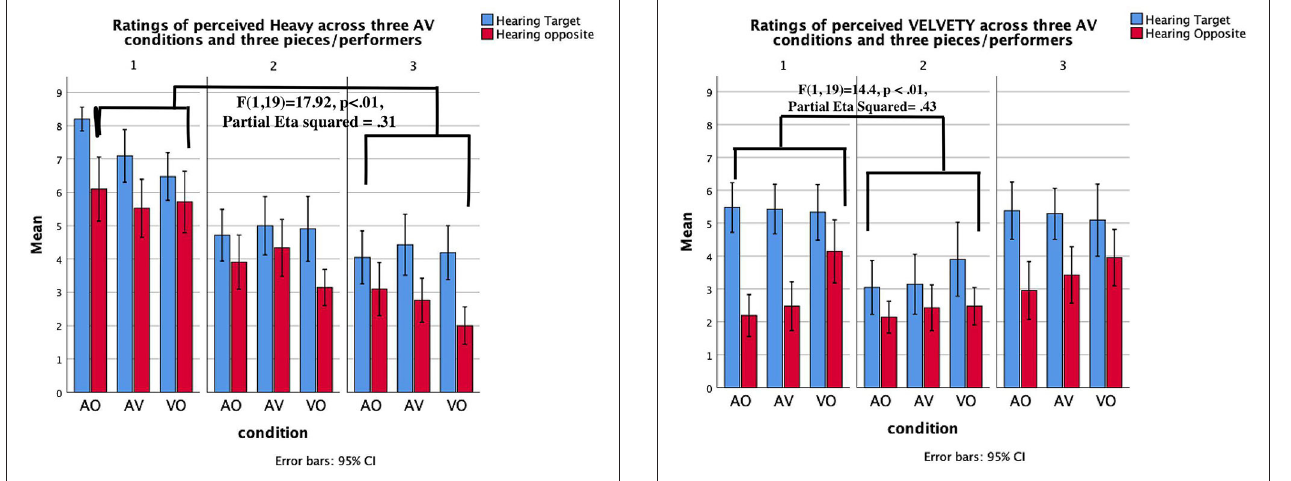
vs. dark, bright vs. light) by three performers. We compared the aural/visual information in pairs, to explore whether the pianists were defaulting to the same performance style/gestures or not when playing these highly correlated timbres. Observable differences were found in these pairs: